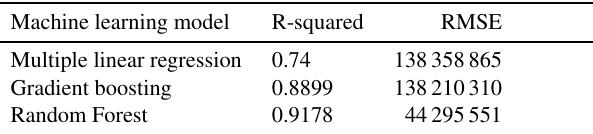
Table 1. Performance of the models.